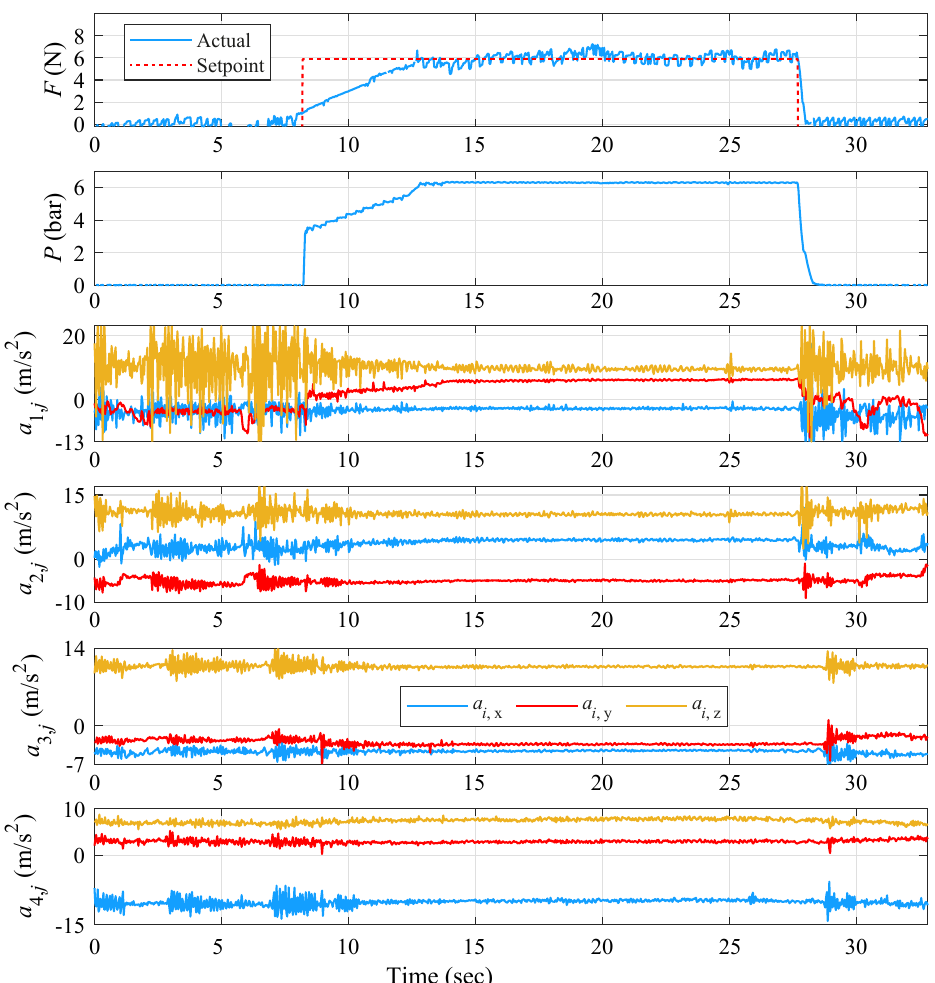
Figure 12. Experimental evaluation of iteration (A) and the effect of applying resisting force to the ET-diagnosed volunteer’s index-finger under closed-loop reference in applied pressure and while the hand is at extended pose; Exp.